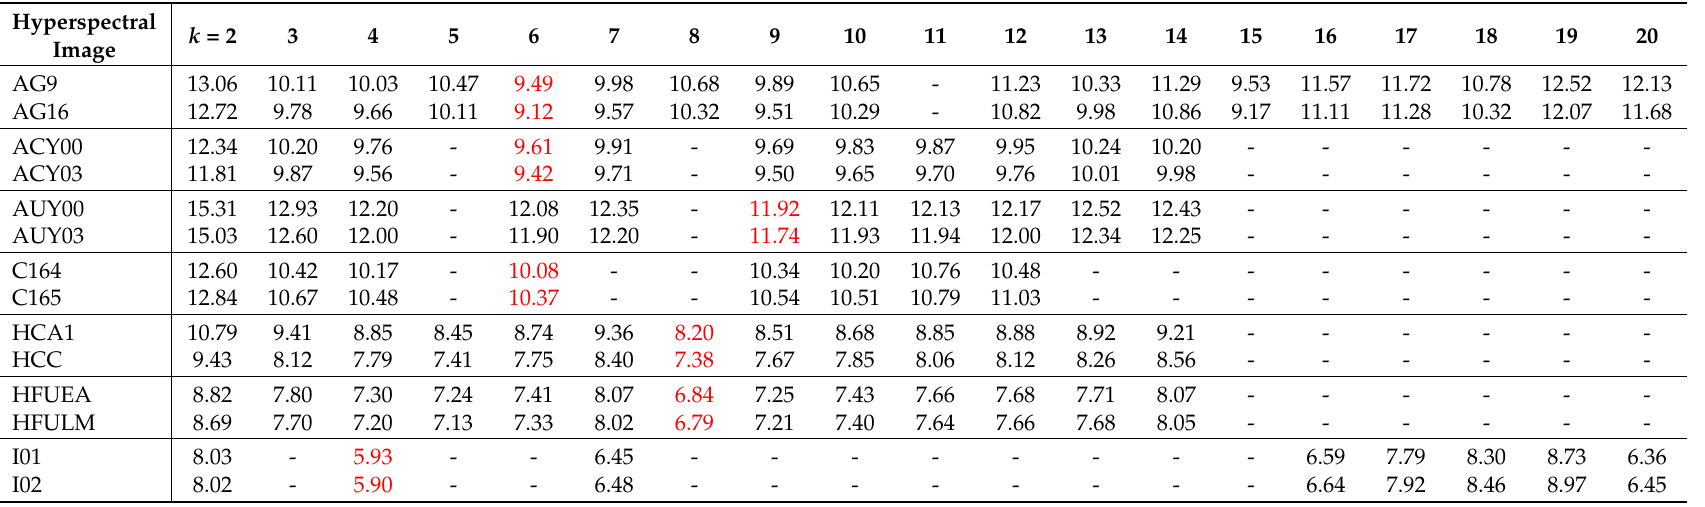
Table 5. Rates (bpppb) for different k -values for some of the testing images. The k -value with the lowest rate is in red.